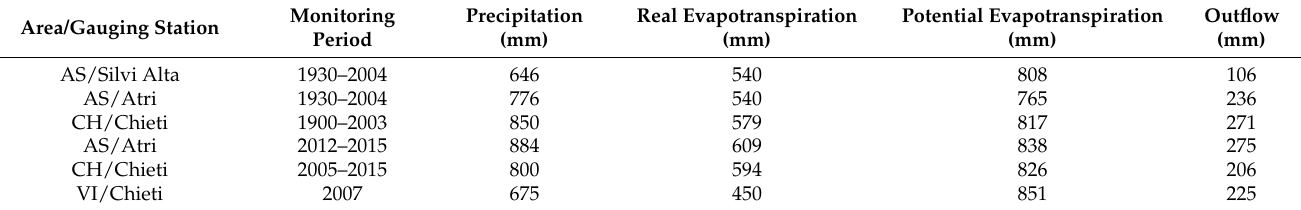
Table 5. Water balance from statistical analysis and from the monitoring period.